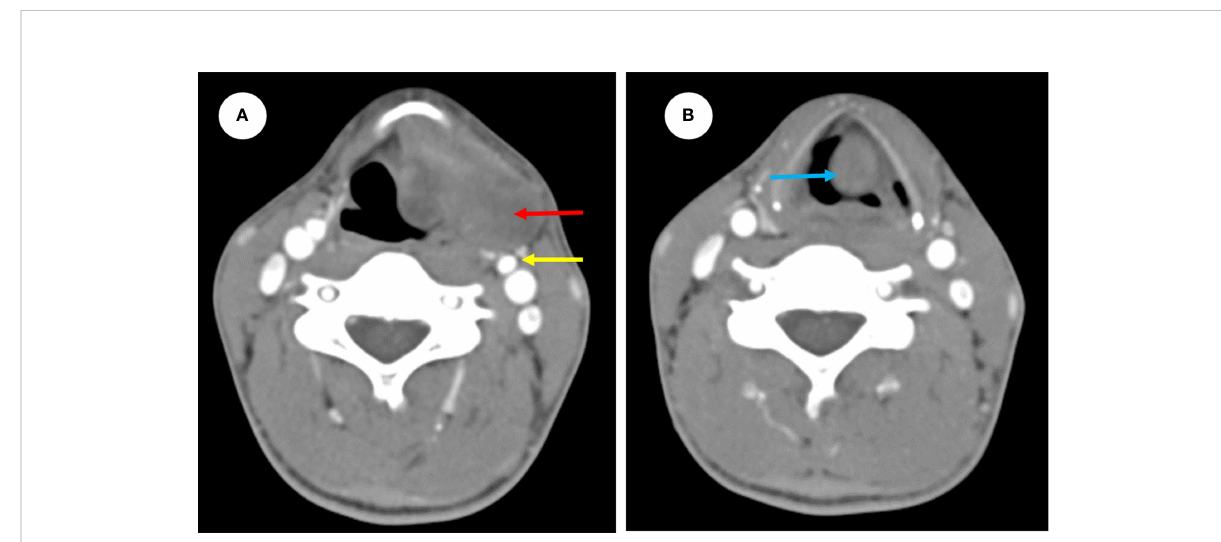
FIGURE 1 Preoperative enhanced CT images showing a mass of irregular density (red arrow) located anterior to the carotid (yellow arrow) extending into both the left side of preepiglottic space (red arrow) (A) and the laryngeal cavity (blue arrow) (B)